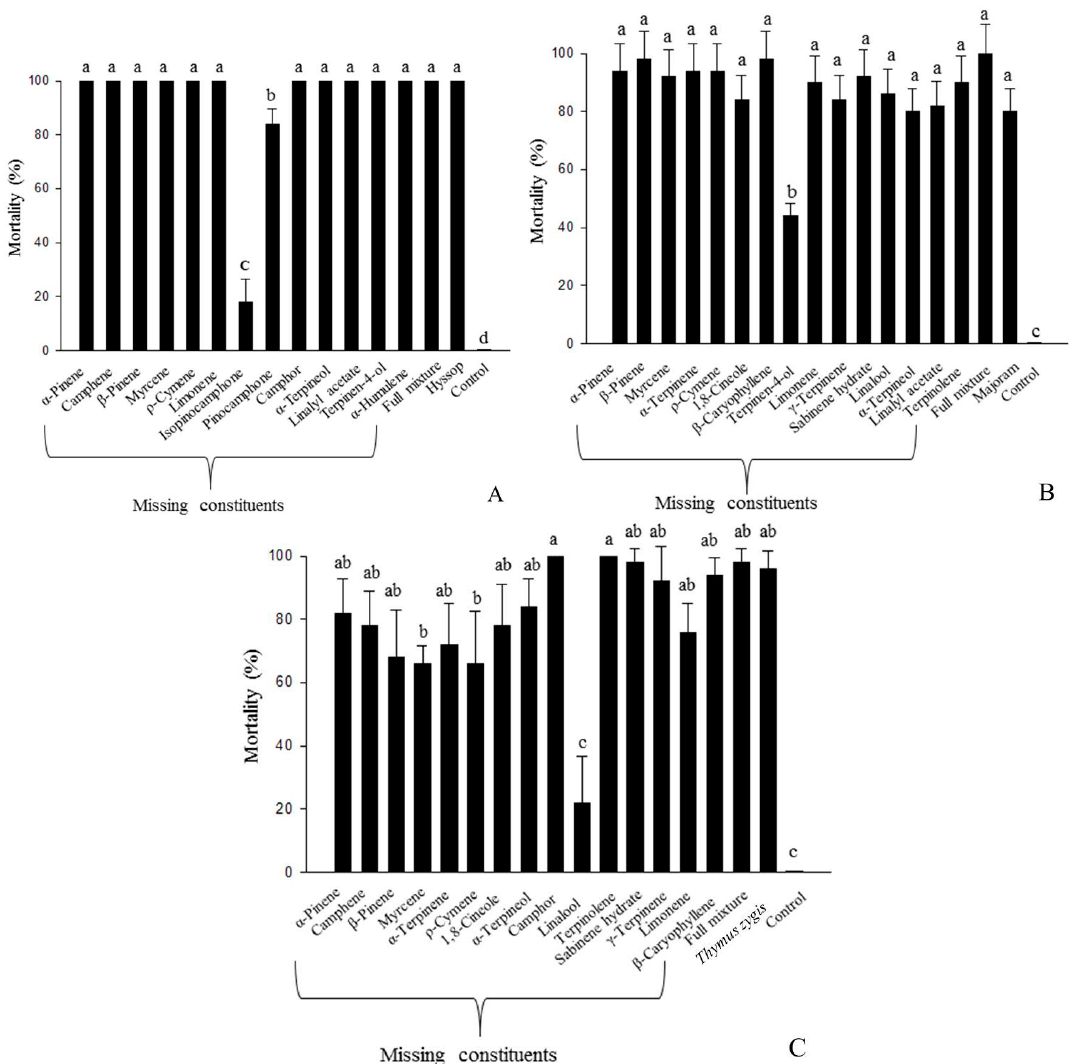
Figure 1. Fumigant toxicities of hyssop ( A ); majoram ( B ); Thymus zygis oil ( C ), a full mixture, and selected blends of the constituents in rice weevil adults with 48 h of treatment. The concentration of hyssop, majoram, and Thymus zygis oil was 12.5 mg/L air. The concentrations of the full mixture of hyssop,